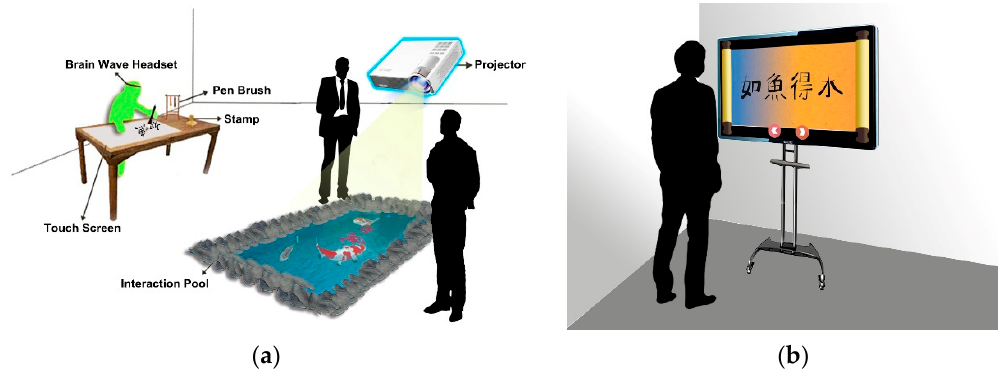
Figure 4. An illustration of the interaction environment and the devices of the proposed system. ( a ) The touch screen at the server site and the interaction pool at the client side. ( b ) The display screen at the remote site, on which the calligraphic work with a color-palette background is shown.